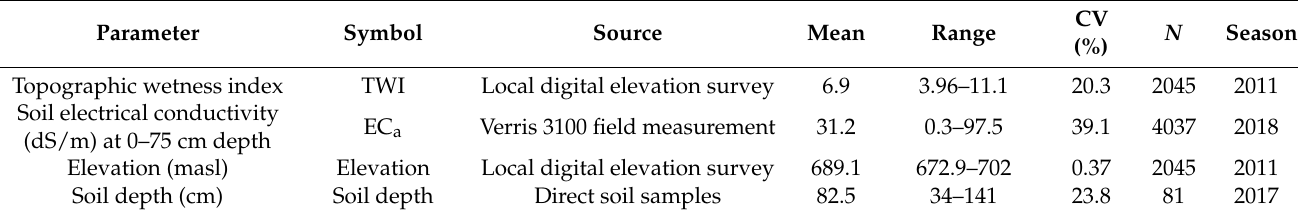
Table 1. Descriptive statistics of terrain and soil variables in the vineyard. CV stands for coefficient of variation (%), N stands for number of data